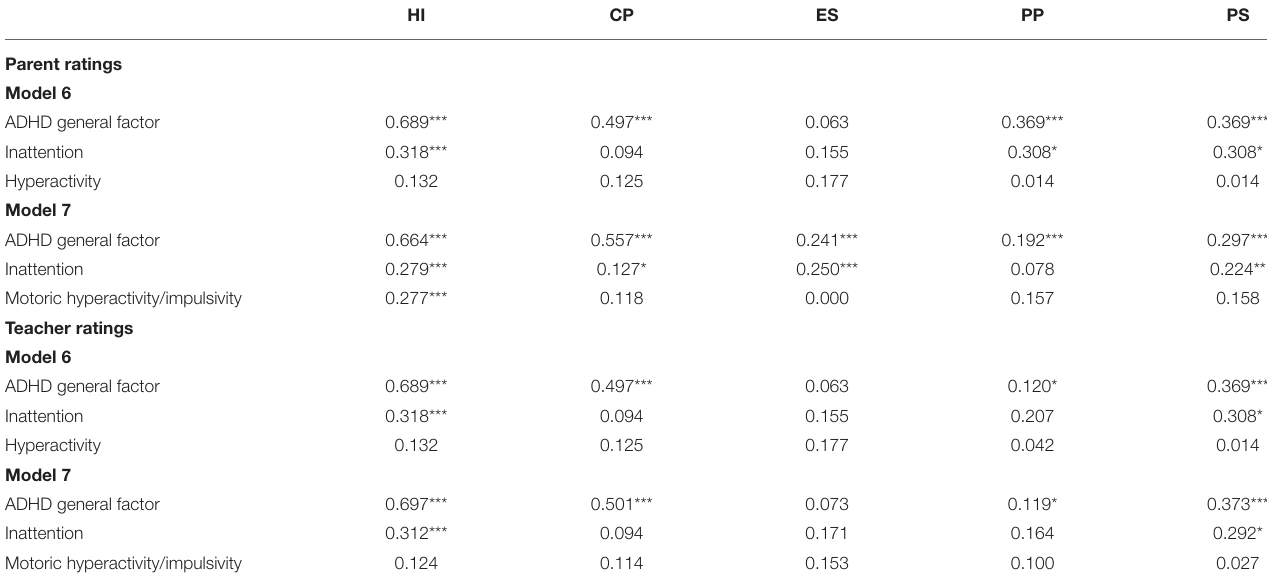
TABLE 3 | Standardized beta coefficients for the predictions of the SDQ subscale scores by the factors in models 6 and 7, based on parent and teacher ratings.